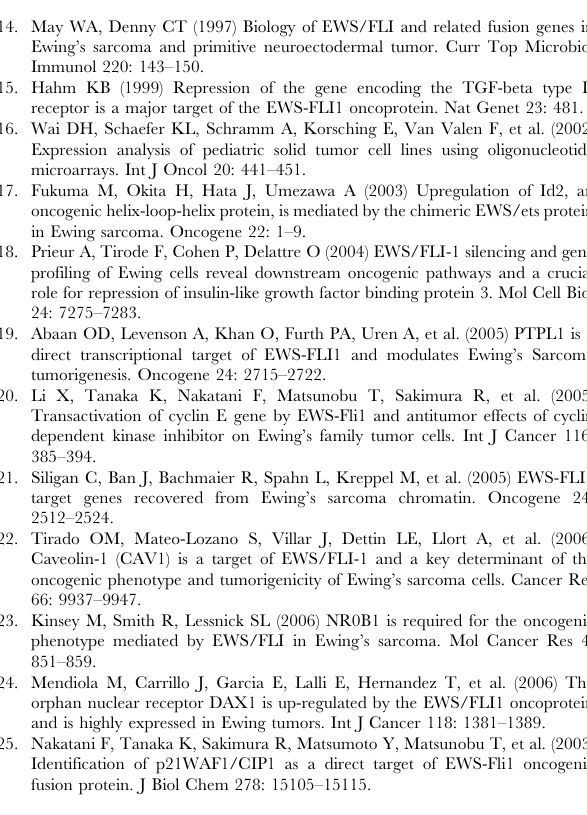
Table S2 Transcription factor consensus sites enrichment in